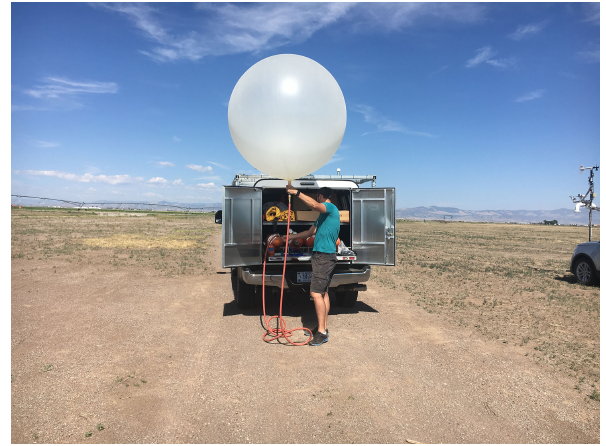
Figure 4. A radiosonde launch at Leach Airfield by Dr. Sean Waugh. Photo credit Dr. Sean Waugh,